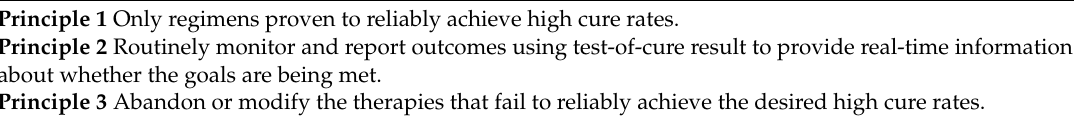
Table 5. Reliable achievement of high cure rates with empiric therapies in clinical practice. Principle 1 Only regimens proven to reliably achieve high cure rates.